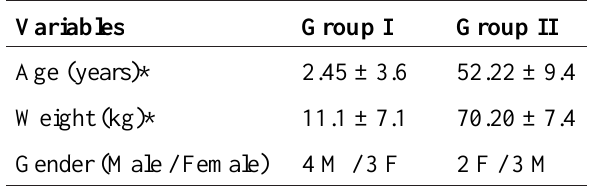
Table 3. Demographic Data